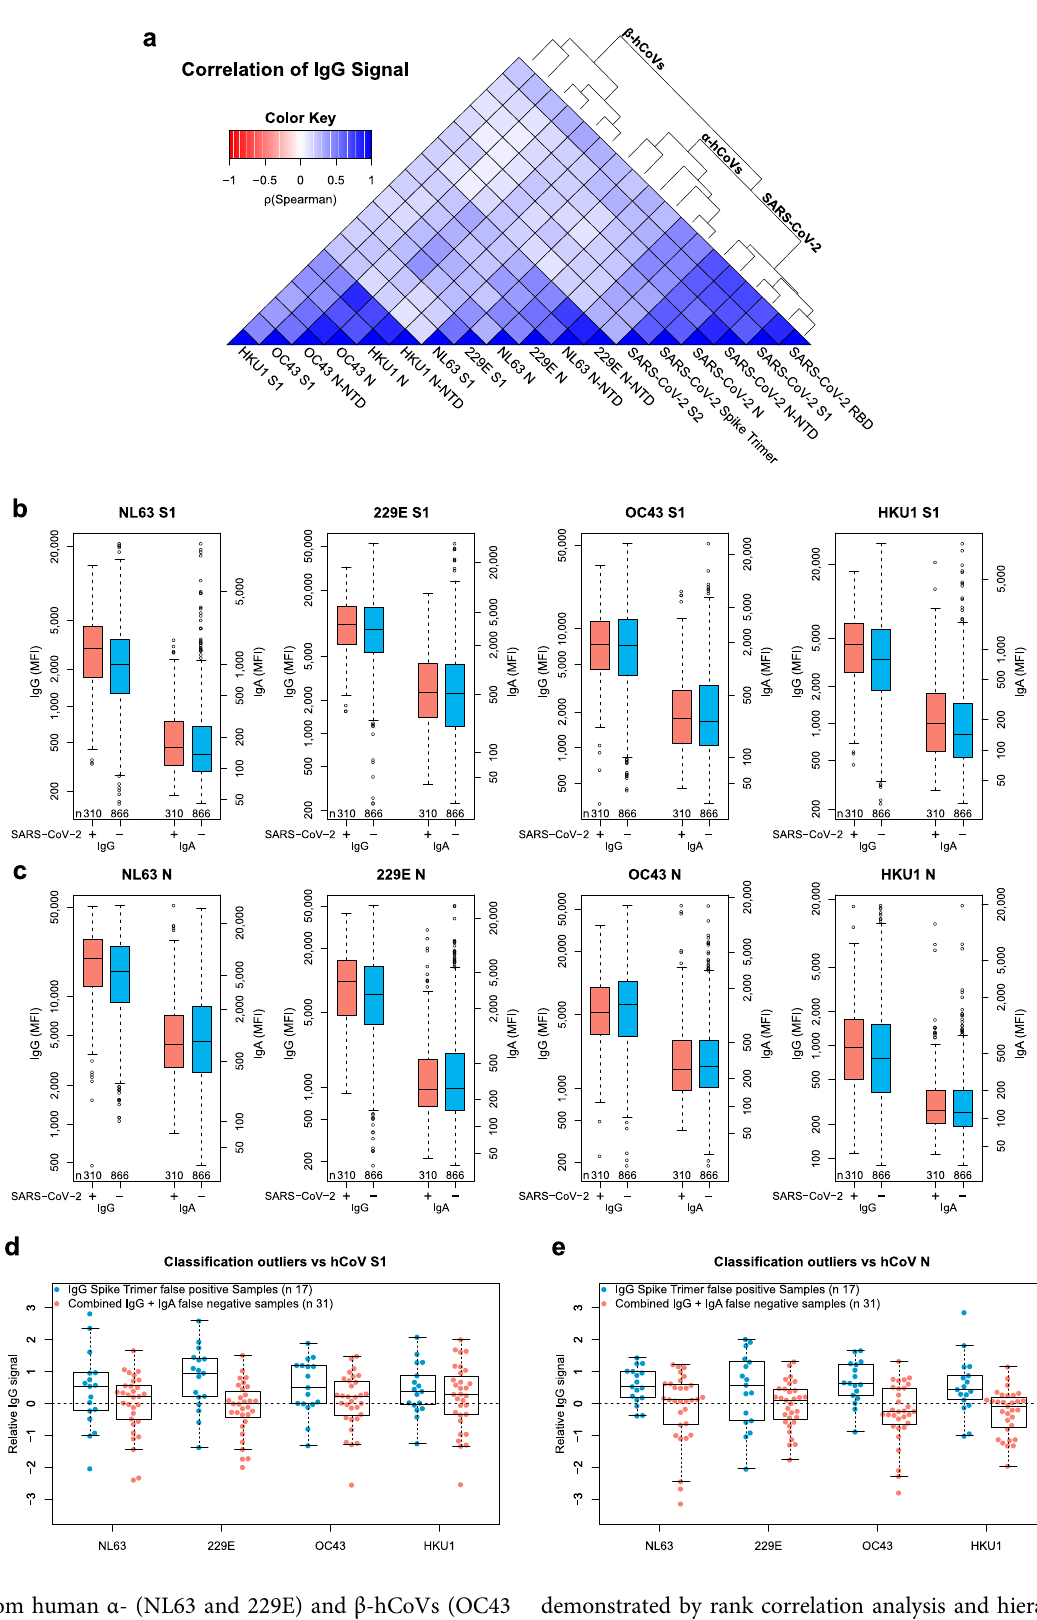
antigens from human α - (NL63 and 229E) and β -hCoVs (OC43 and HKU1) in our MultiCoV-Ab panel (Supplementary Fig.